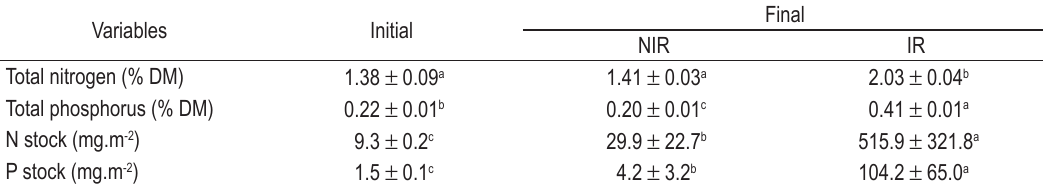
Table 3. Means and standard deviations of the concentrations and stocks of nitrogen and phosphorus in the biomass of Salvinia molesta in the non-impacted reservoir (NIR) and the effluent-impacted reservoir (IR), at the beginning and end of the